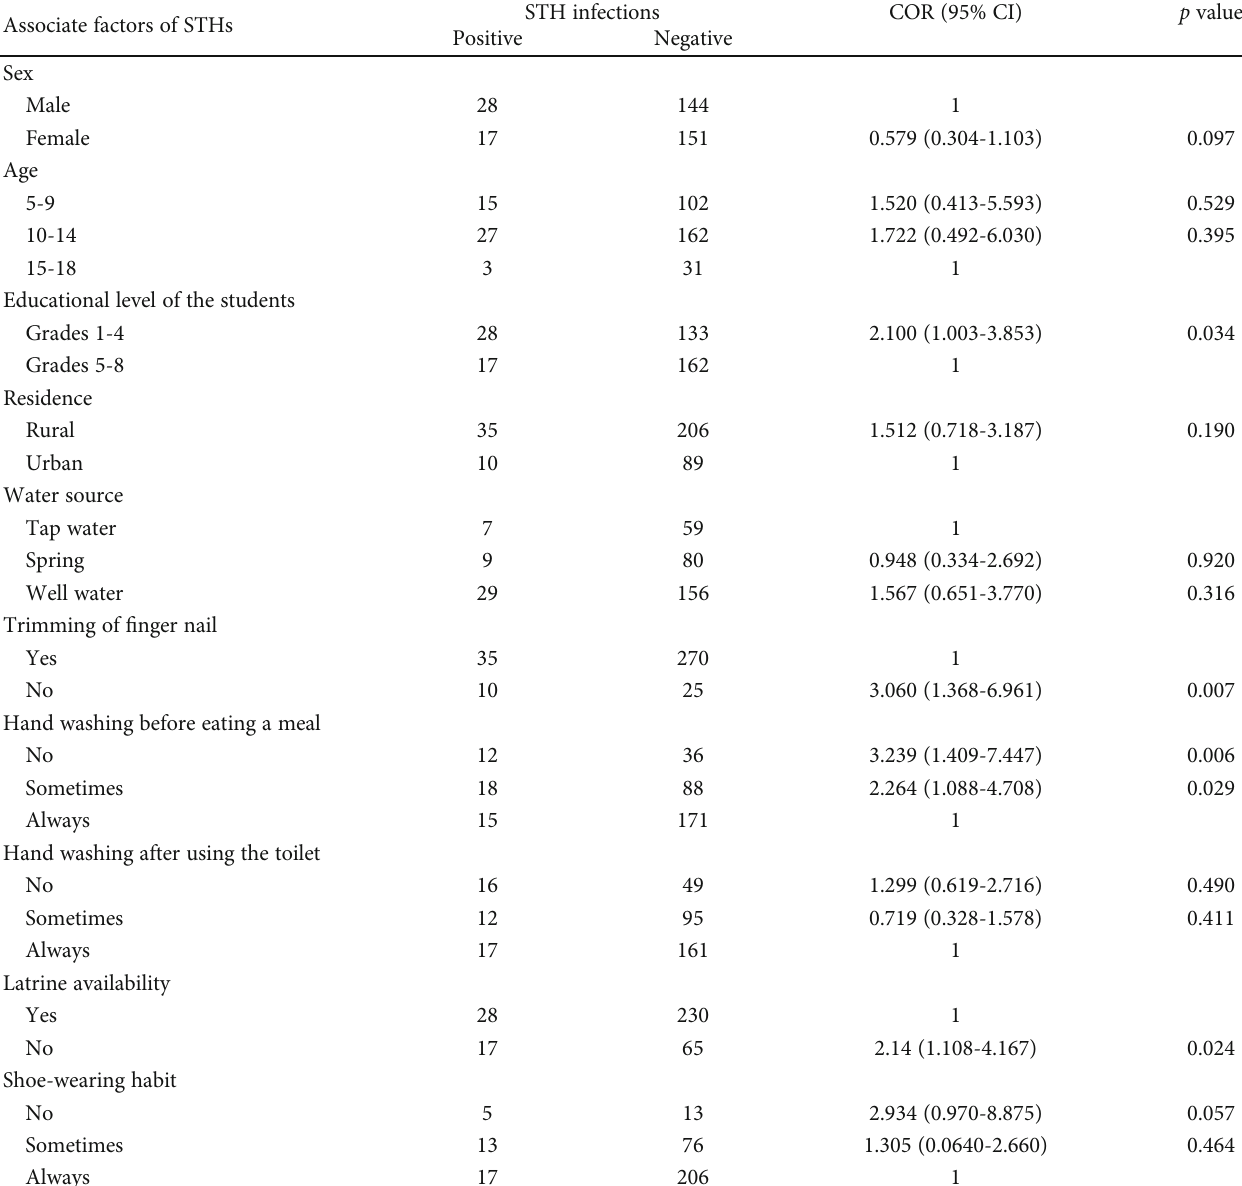
Table 3: Bivariate analysis of association factors of STH infection among Hiruy Abaregawi primary school children from March to April, 2019, Debre Tabor town, North West